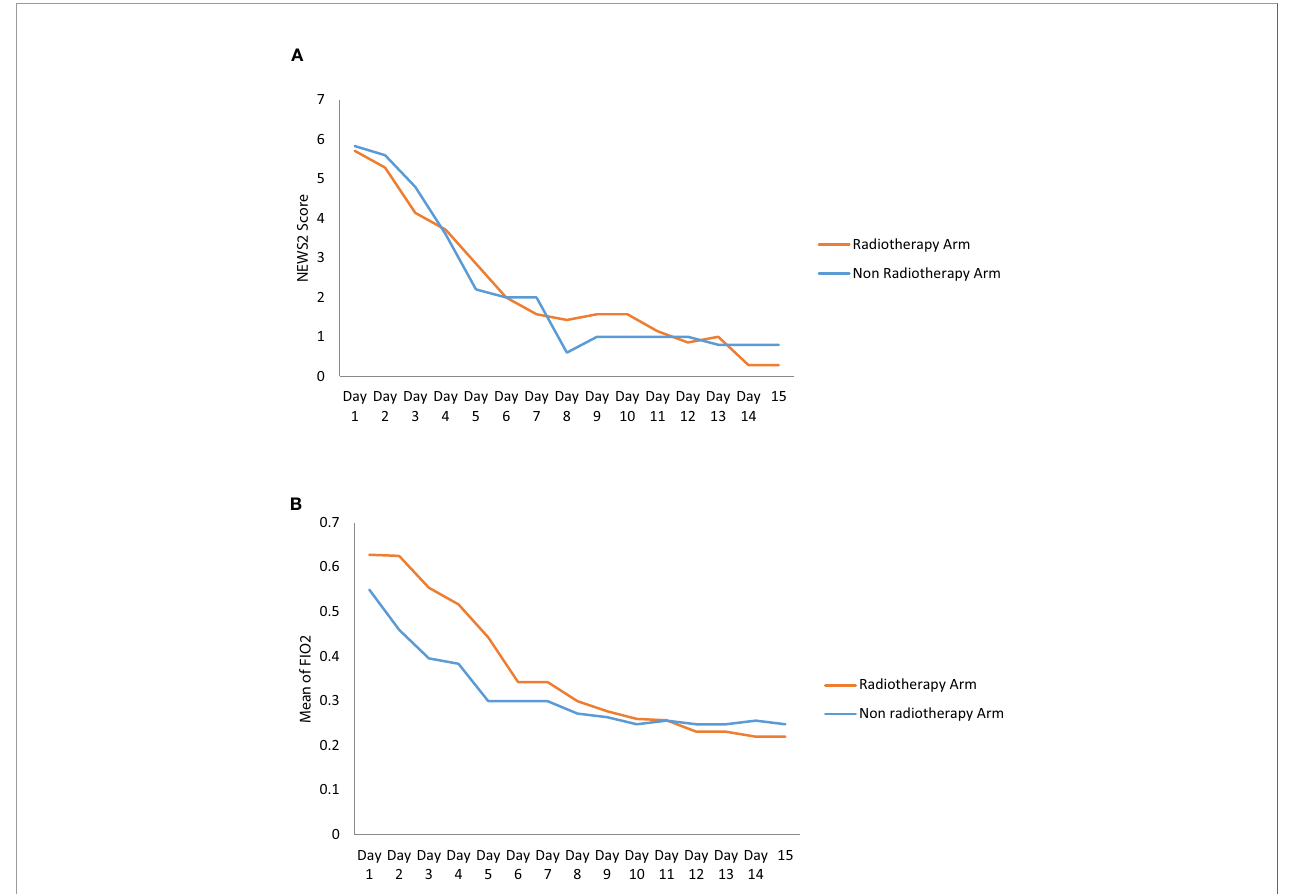
FIGURE 2 | (A) The graph shows the change of NEWS2 Score in RT and Non RT arm on Day 1 and serial follow-up. (B) The Graph shows the change of mean of Fio2 in RT and Non RT arm on Day 1 and serial